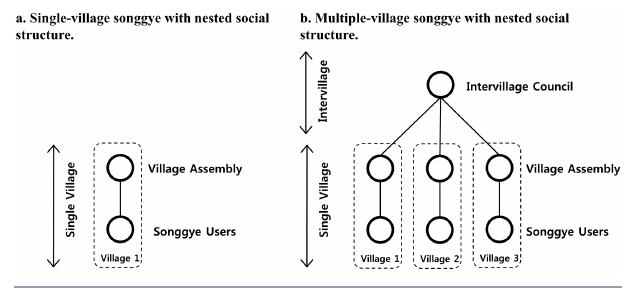
Fig. 4 . Types of vertical linkages in songgye social structure.